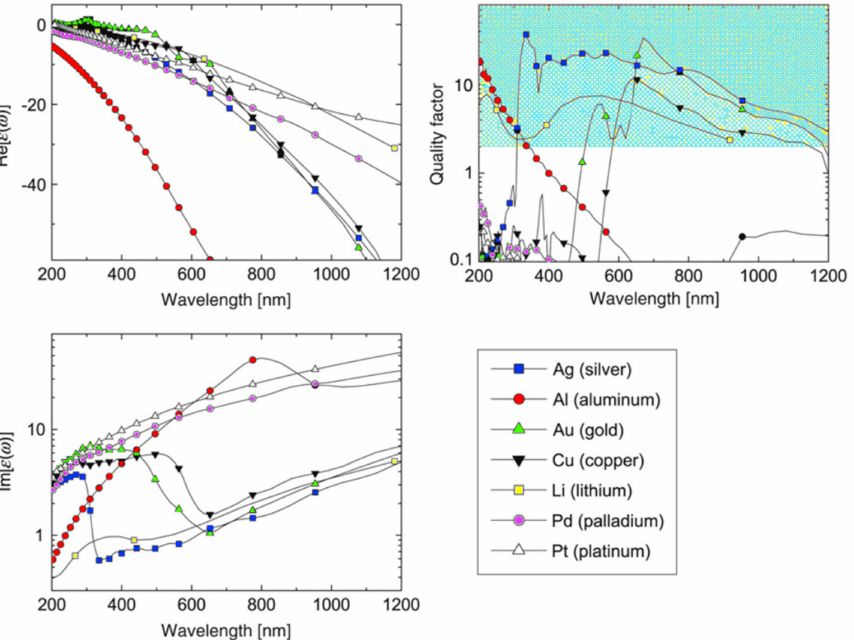
Figure 1. Optical properties of a selection of metals. The real ( top ) and imaginary ( bottom ) parts of ε are plotted against wavelength on the left. Also shown ( top-right ) is the predicted approximate Q-factor of LSPR for a metal/air NP interface. The shaded area is the area of interest to many plasmonics applications. Adapted with permission from